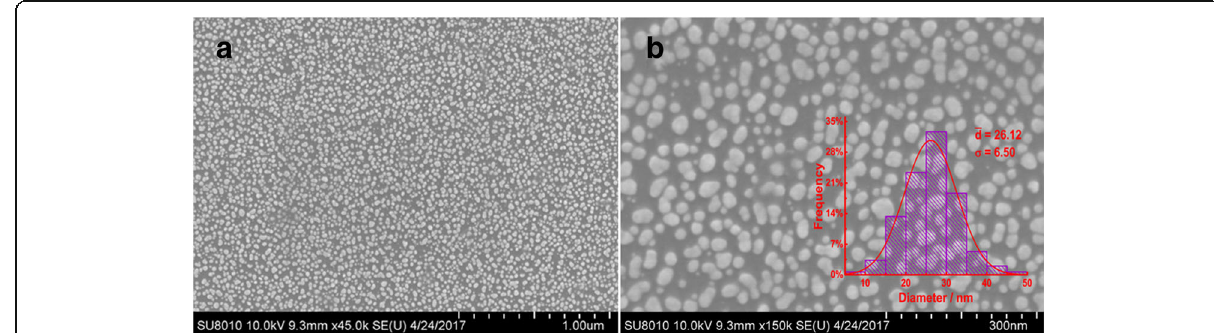
Fig. 1 SEM images of Au/GCE at lower ( a ) and higher magnification ( b ). Inset : corresponding Au nanoparticles size distribution histogram